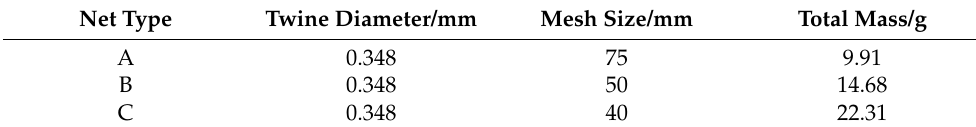
Table 1. The net types.